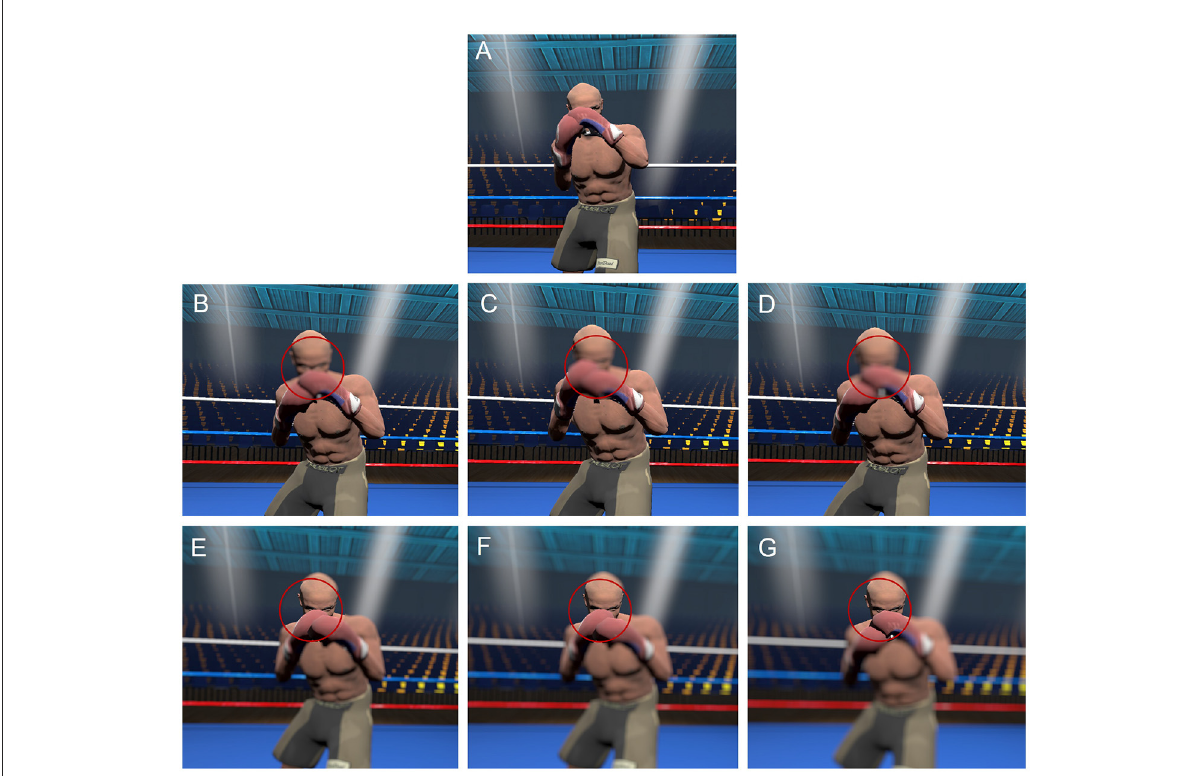
FIGURE1 Representation of the viewing conditions. (A) control, (B) central blur level 1, (C) central blur level 2, (D) central blur level 3, (E) peripheral blur level 1, (F) peripheral blur level 2, (G) peripheral blur level 3. VR user view. For emphasis, we have overlaid an outline to the gaze-contingent window but this was not visible to